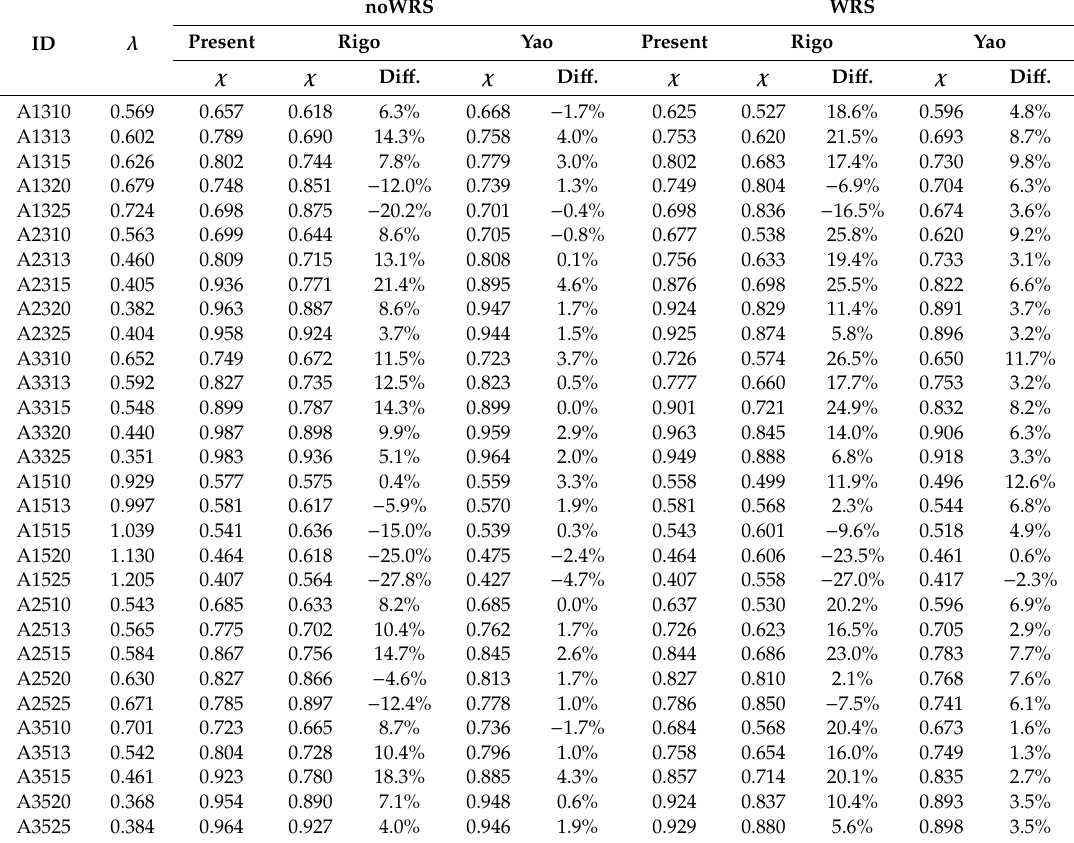
Table A2. Results obtained in the present study and in the ISSC’2000 benchmark calculations for the ultimate strength of angle-bar sti ff ened plates [11].